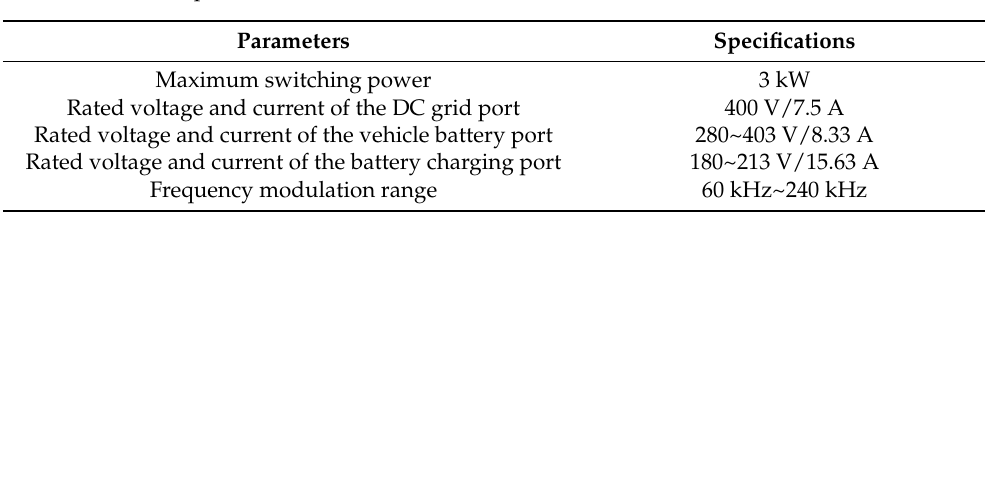
Figure 16. The prototype of the proposed converter. ( a ) Top view; ( b )Right side view. Table 3. Electrical specifications of the converter.